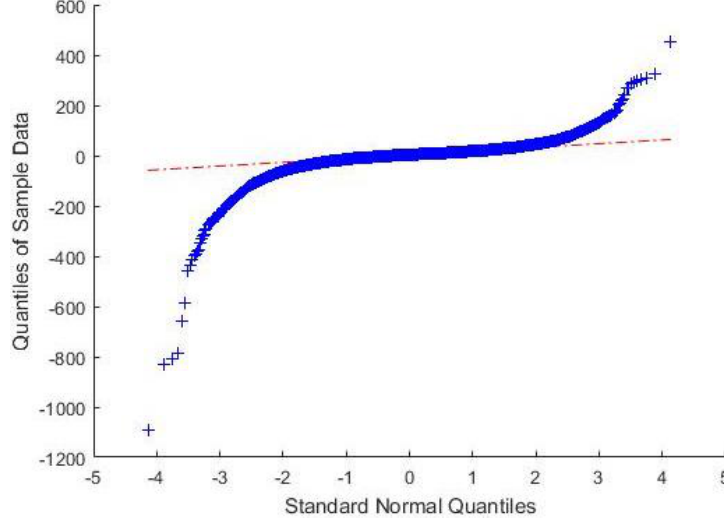
Figure 11. Quantile-quantile plot of sample data (“pure” turnaround delay) versus standard normal.